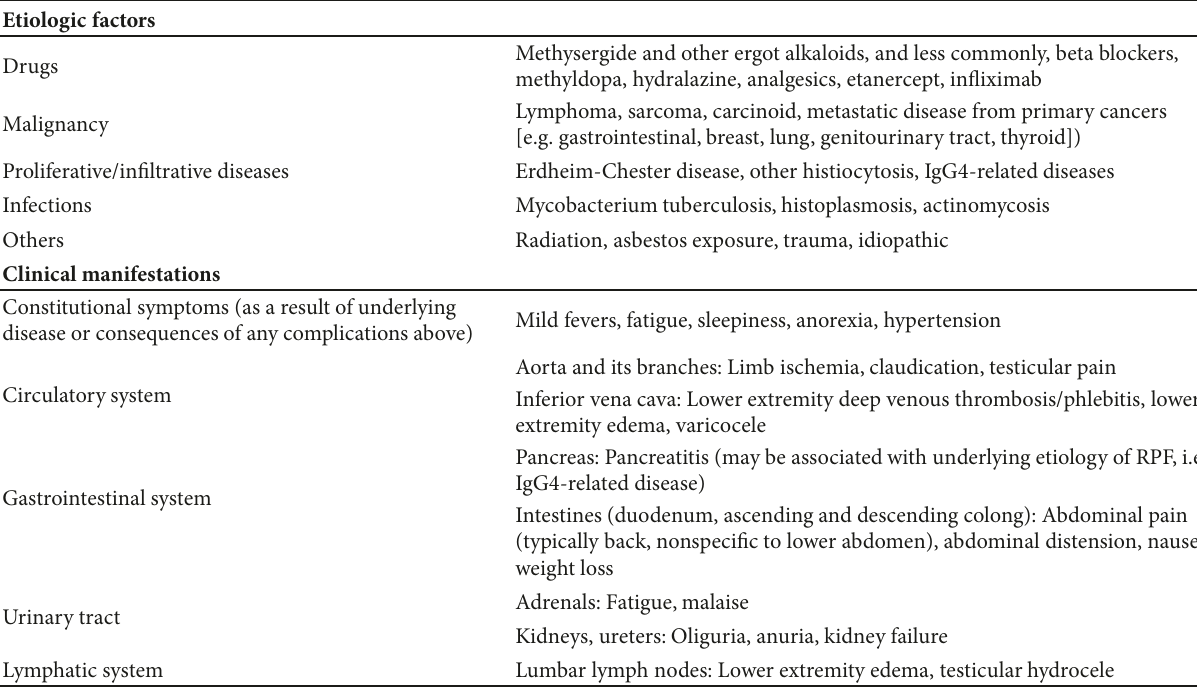
Table 1: Etiologic factors and clinical manifestations of retroperitoneal